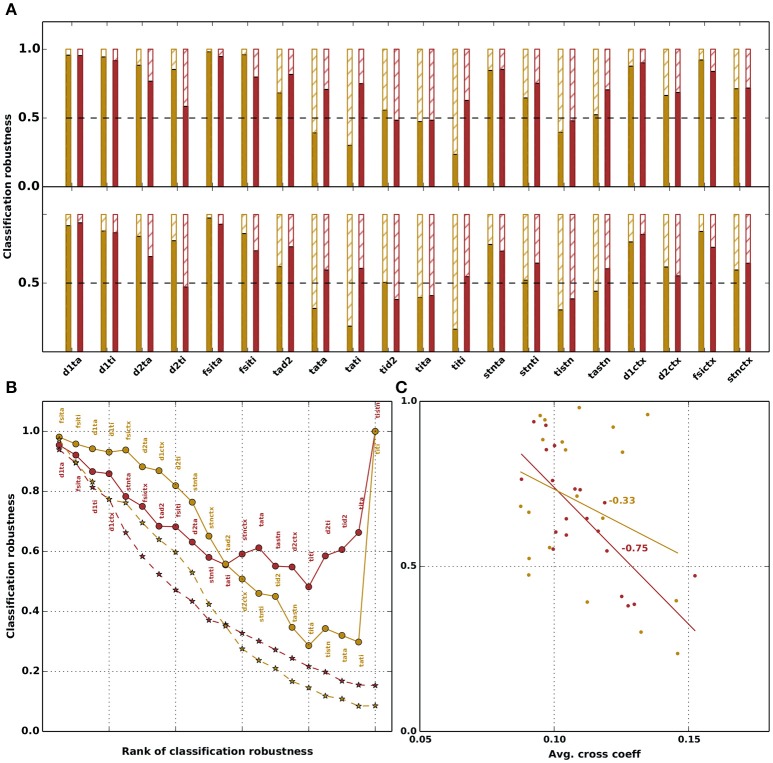
Robustness of network classification for physiological (yellow) and parkinsonian (red) networks with respect to manipulation of the parameters. (A) Classification robustness, i.e., fraction of networks that retain (solid bars) or lose (hatched bars) their respective classification under manipulation of each free parameter. Top row: parameter value is replaced by the mean of the corresponding distribution (replace by mean). Bottom row: parameter values are randomly shuffled within the ensembles of network configurations with the same classification (shuffle); classification robustness is averaged over ten shuffle realizations. (B) Classification robustness as a function of the number of parameters manipulated in a cumulative fashion. Circles: replace by mean. Stars: shuffle. Order of manipulations is given by decreasing order of classification robustness in (A).This order is fixed for the replace by mean manipulation (see annotations next to circles); for the shuffle manipulation (stars), the order depends on the realization of the random shuffle. Stars depict robustness averaged over ten shuffle realizations. (C) Classification robustness as a function of the mean correlation coefficient of each free parameter (from matrices shown in Figures 4B,C). A line fit shows a strong dependence with a R-value of −0.75 for parkinsonian networks and a weak dependence with R-value of −0.33 for physiological networks.